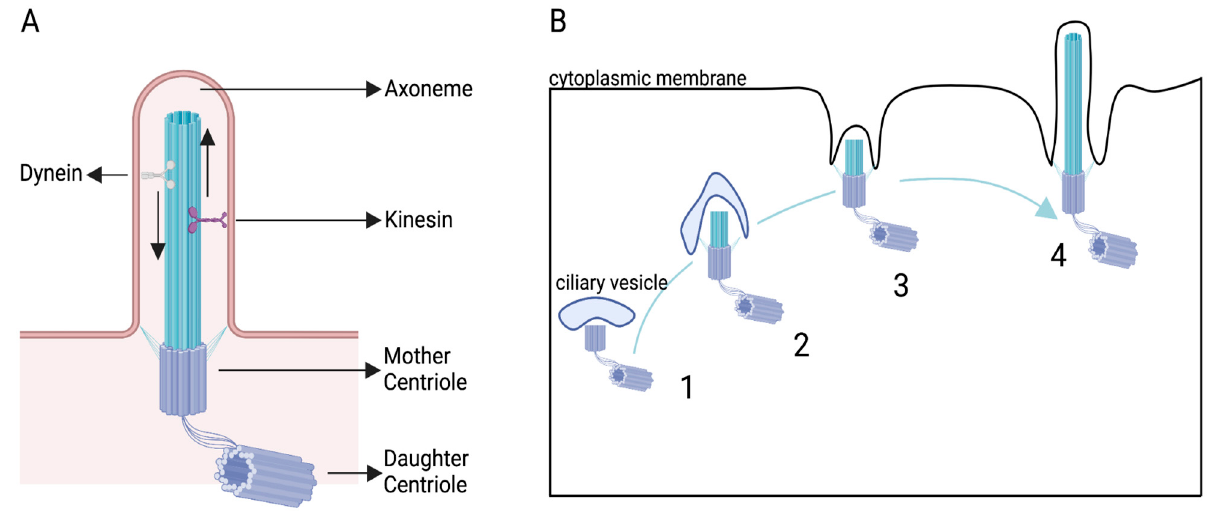
Figure 1 . Ciliogenesis . ( A ) Scheme of the PC. ( B ) Model of ciliogenesis, B1, and formation of the ciliary vesicle adjacent to the mother centriole. B2, the PC starts to grow intracellularly. B3, the basal body moves within the cell to reach the membrane where the ciliary vesicle fuses with the cytoplasmic membrane. B4, the PC expands extracellularly.